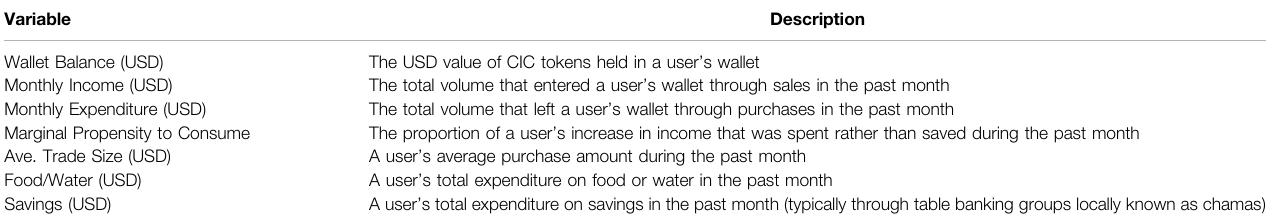
TABLE 4 | Individual outcome variables measured post-treatment. Variable Description